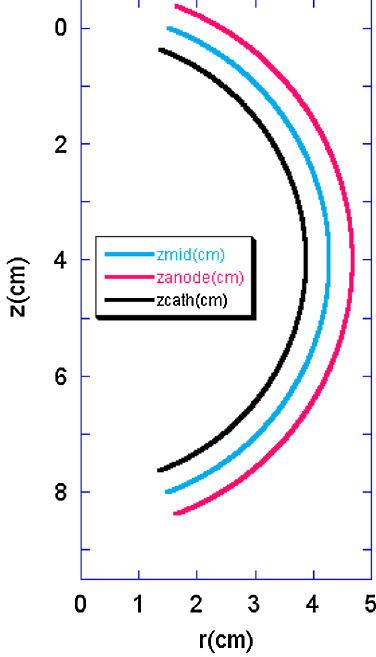
FIG. 2. (Color) Optimal TL for constant gap and equal inner and outer radii. Electrode and midgap curves (cathode in black, anode in red, midgap in blue) for the optimal TL for constant 0.8 cm gap. The end points of the midgap curve are r 1 : 5 cm , l z ¼ 8 cm . Notice that this minimum inductance line is given by a circumference in the R , Z plane. In fact, for this example its vacuum inductance is 5.5 nH instead of the 8.7 nH of the straight coaxial line going through the same midgap end points.